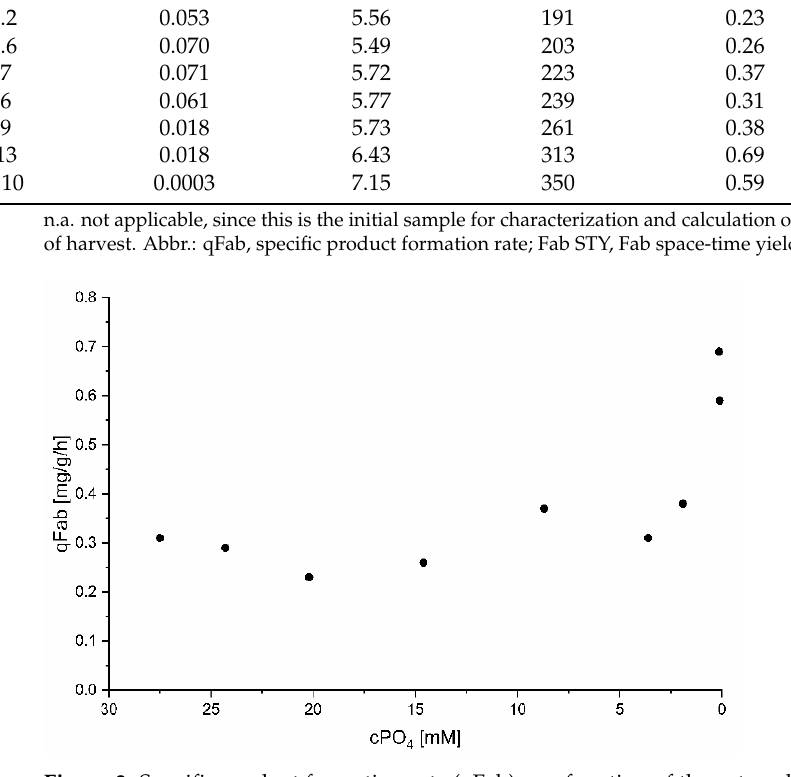
Figure 3. Specific product formation rate (qFab) as a function of the extracellular PO 4 concentration (cPO 4 ) during fed-batch cultivation until PO 4 starvation. The average standard deviation was quantified with 9.69%.